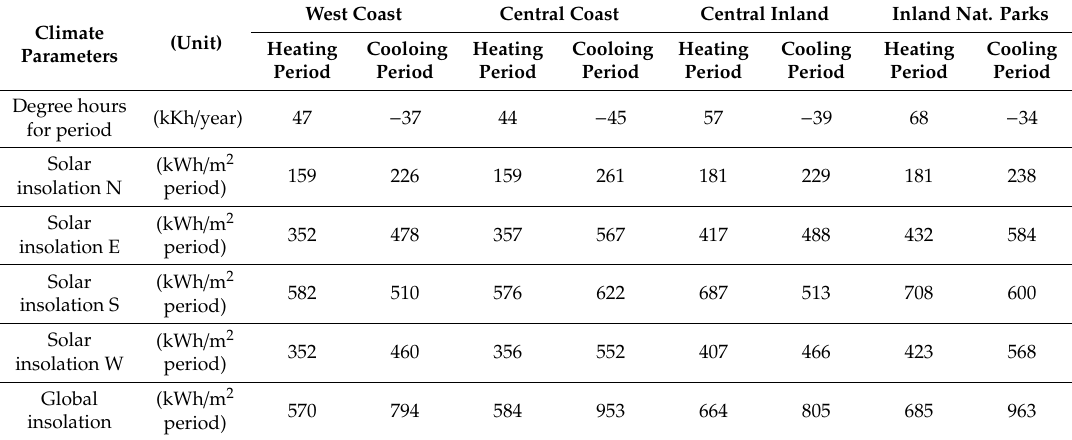
Table 6. Climate parameters of the representative location of each sub-region: degree hours, solar insolation for heating and cooling periods.